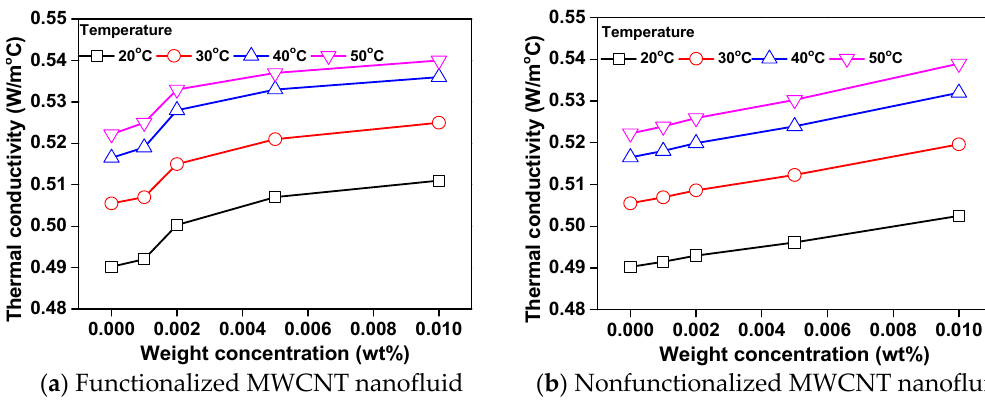
Figure 10. Thermal conductivity of the ( a ) functionalized and ( b ) nonfunctionalized MWCNT nanofluid with weight concentration for different temperatures.